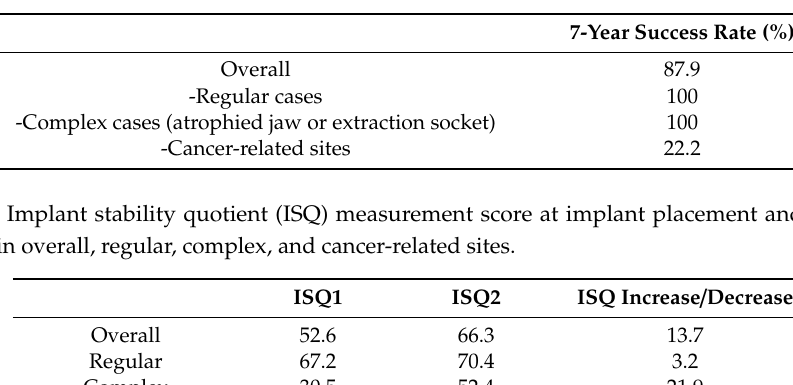
Table 4. Success rates of implant in each category.